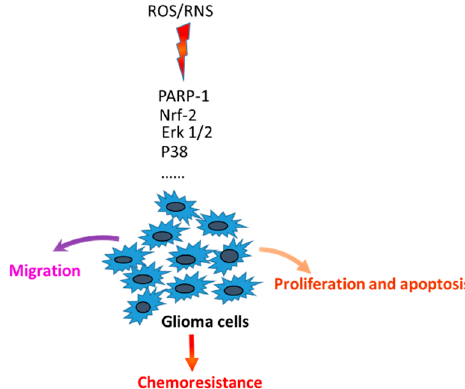
Figure 1. Mechanisms of glioma cells malignancy. ROS and RNS are involved in glioma cells malignancy through the activation of different cellular mediators.